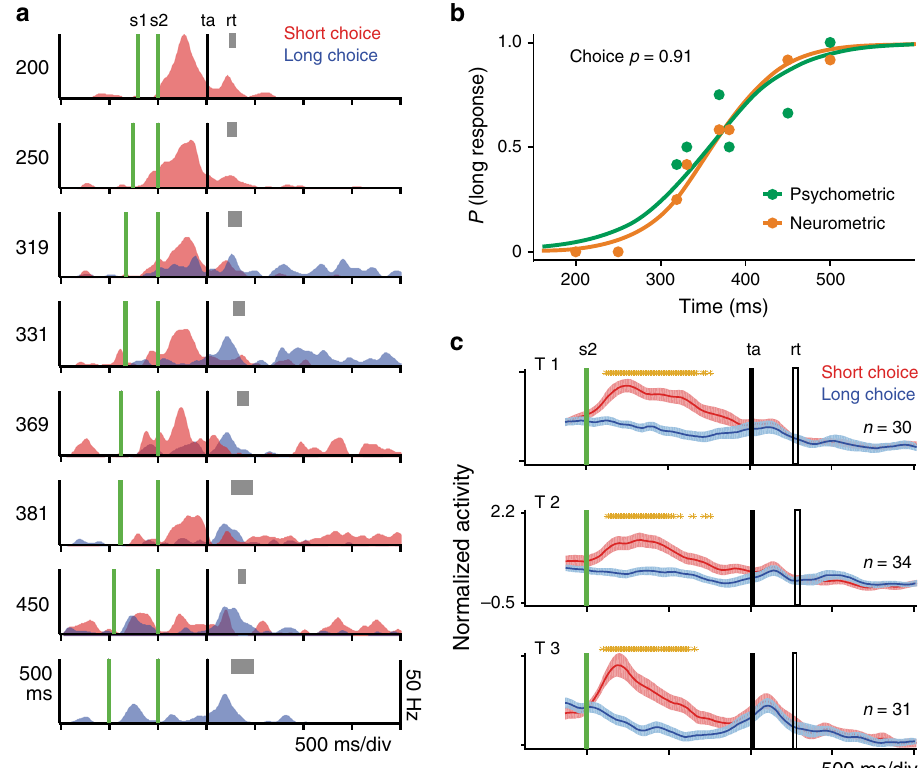
Fig. 7 Category-selective neurons. a Mean SDFs of a category-selective neuron of monkey 2 whose activity was modulated during the delay epoch by the future monkey ’ s categorical choice for short durations. The activity is segregated by the monkey ’ s choice (red: short, blue: long choice) and interval duration (indicated to the left of each graph). Same notation as in Fig. 2a. b Psychometric performance (green) of the monkey during the recording of the neuron in a , whose neurometric function is shown in orange. The choice probability of this cell was close to 1 and the χ 2 -test on the contingency table calculated between the decoded and the observed monkey ’ s choices across all trials was signi fi cant ( x 2 = 54.43; p < 0. 001). c Population activity (mean ± SEM) of neurons of monkey 1 whose fi ring rate is signi fi cantly higher for short response trials during the delay epoch (red function). Orange asterisks indicate: (1) t -test signi fi cant differences in ten millisecond, non-overlapping bins (over the population SDF, short vs. long choices, 95% bootstrap con fi dence interval, 100 iterations). The single cell ( a ) and the population activity ( c ) are aligned to the presentation of the second stimulus